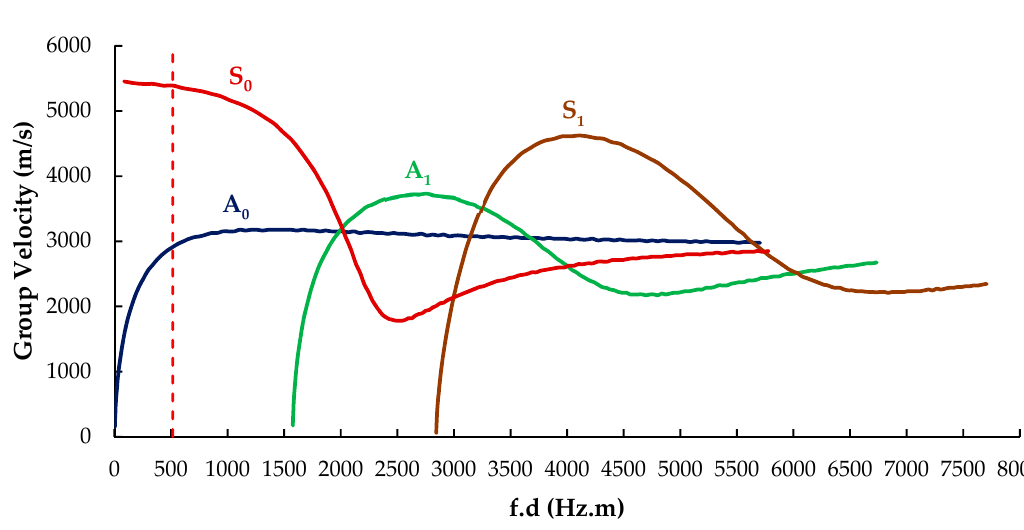
Figure 2. Group velocity dispersion curves for aluminum plate.